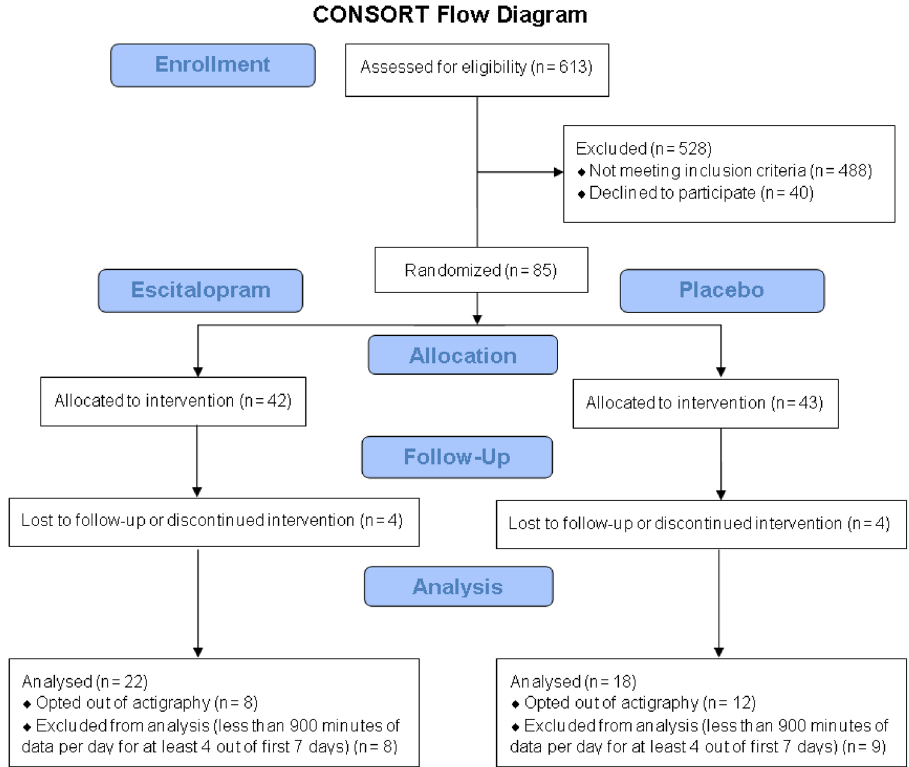
Fig. 1 CONSORT fl ow diagram depicting the progression of participants through the actigraphy study. CONSORT consolidated standards of reporting